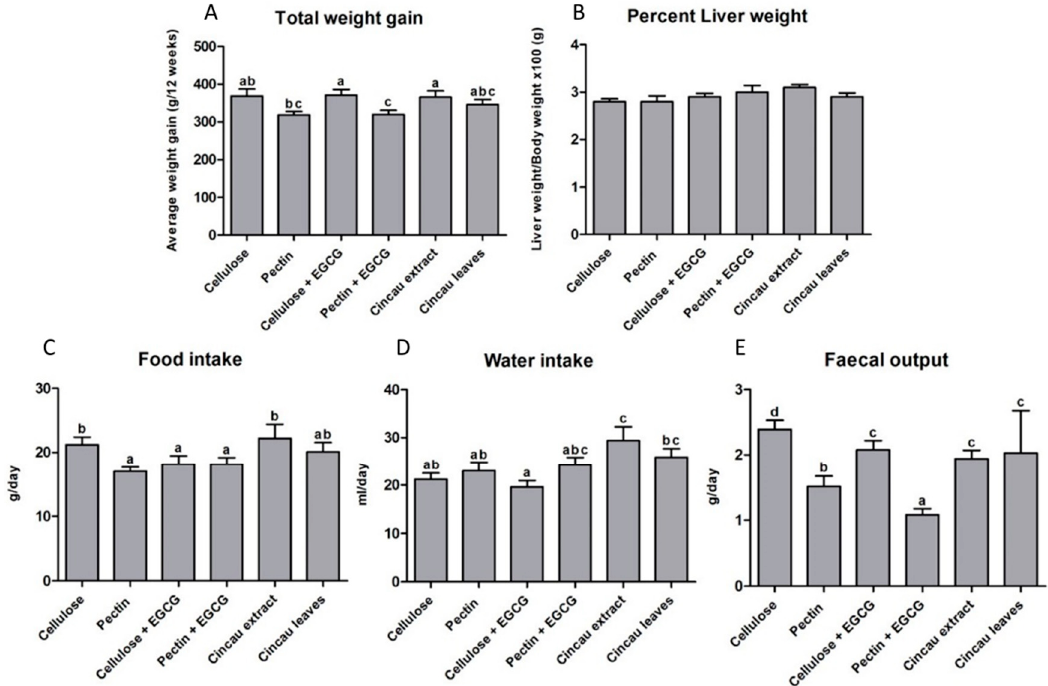
Figure 1. Effects of different dietary fibre diets on body weight gain ( A ), percent liver weight ( B ), food and water intake ( C , D ), and faecal output ( E ). Means with a different superscript (letters on the bar) are statistically significantly different when the LSD method was applied for post-hoc analysis p ≤ 0.05 ( n = 12). EGCG, 0.1% Epigallocatechin ‐ 3 ‐ gallate.